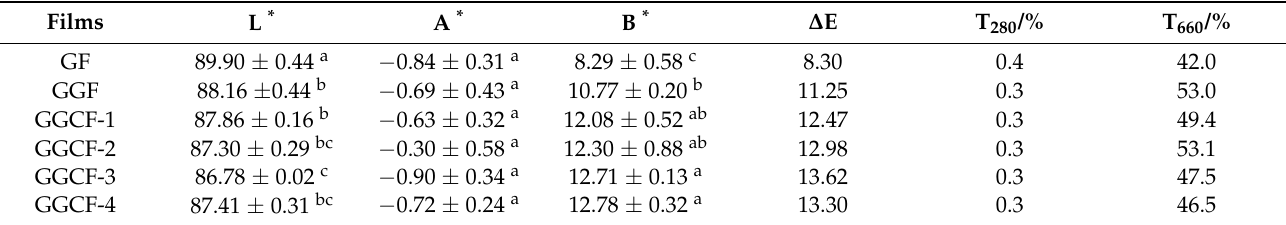
Table 1. Apparent color and light transmittance of